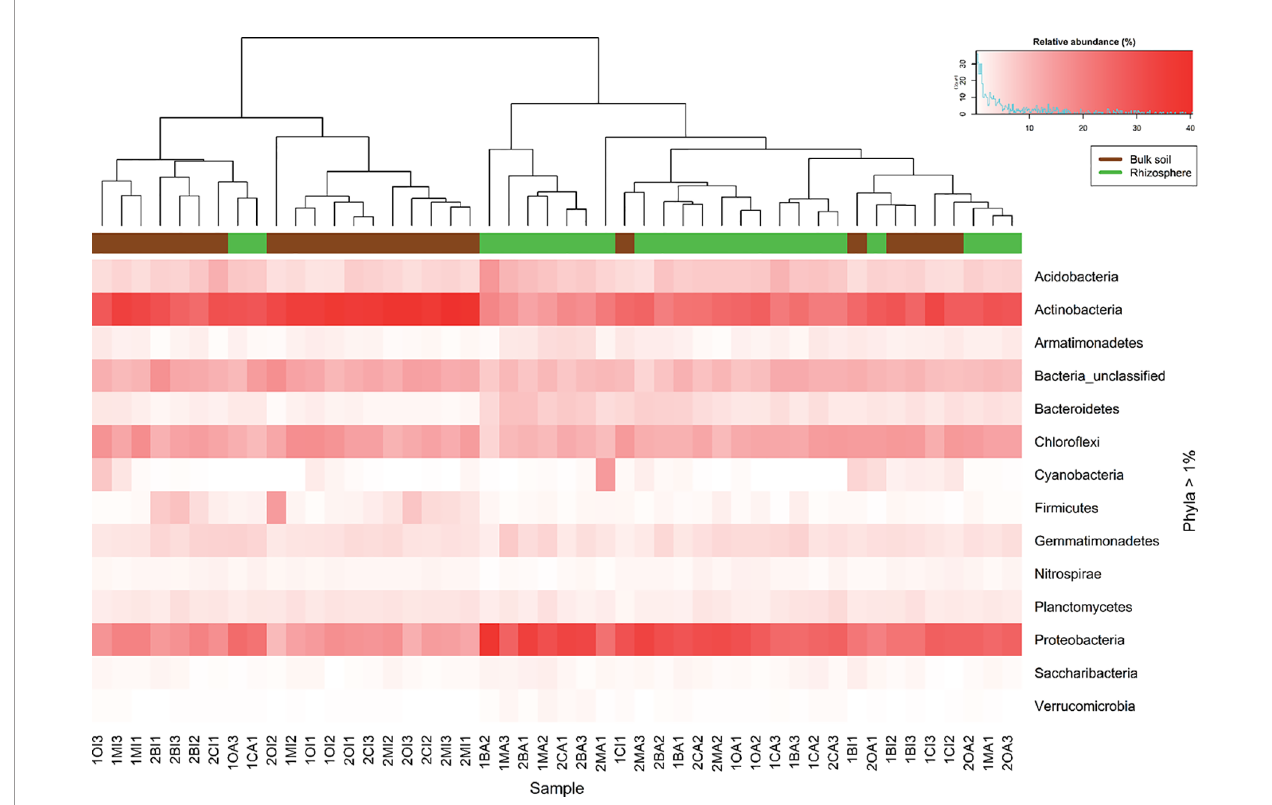
FIGURE 1 | Heatmap constructed using the relative abundance of the identi fi ed phyla in all samples. The intensity of red color represents relative abundance. Superior dendogram is the result of the clustering analysis using Bray Curtis dissimilarity index, each sample is colored according to their origin, rhizosphere (green) or bulk soil (brown).